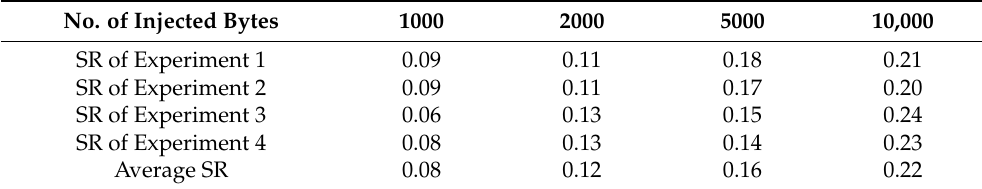
Table 4. SR of the randomly injecting method adopting mid-file